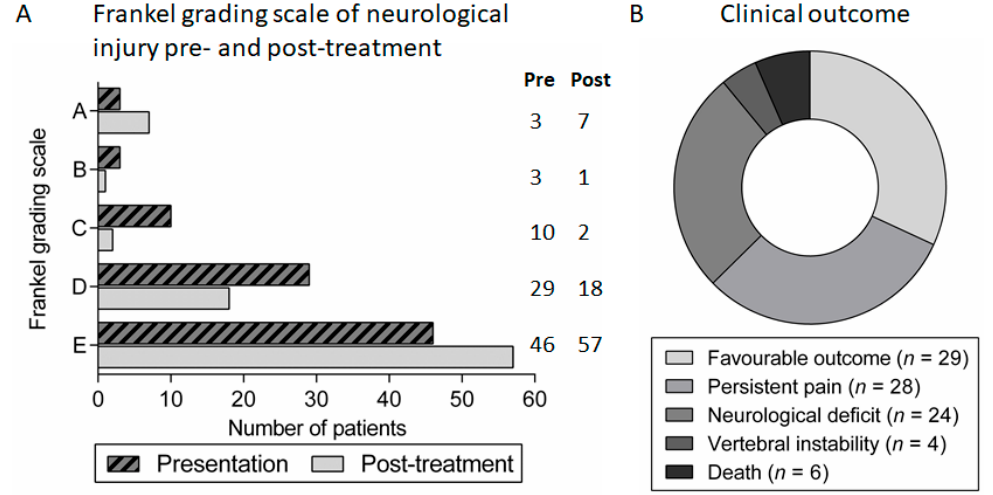
Figure 5. Clinical outcomes in patients with spondylodiscitis: ( A ) Frankel grading scale of neurological injury in patients with spondylodiscitis at presentation and at follow-up review after treatment; and ( B ) proportion of patients with different clinical outcomes following treatment for spondylodiscitis. Table 2. Factors predicting outcome from spondylodiscitis.